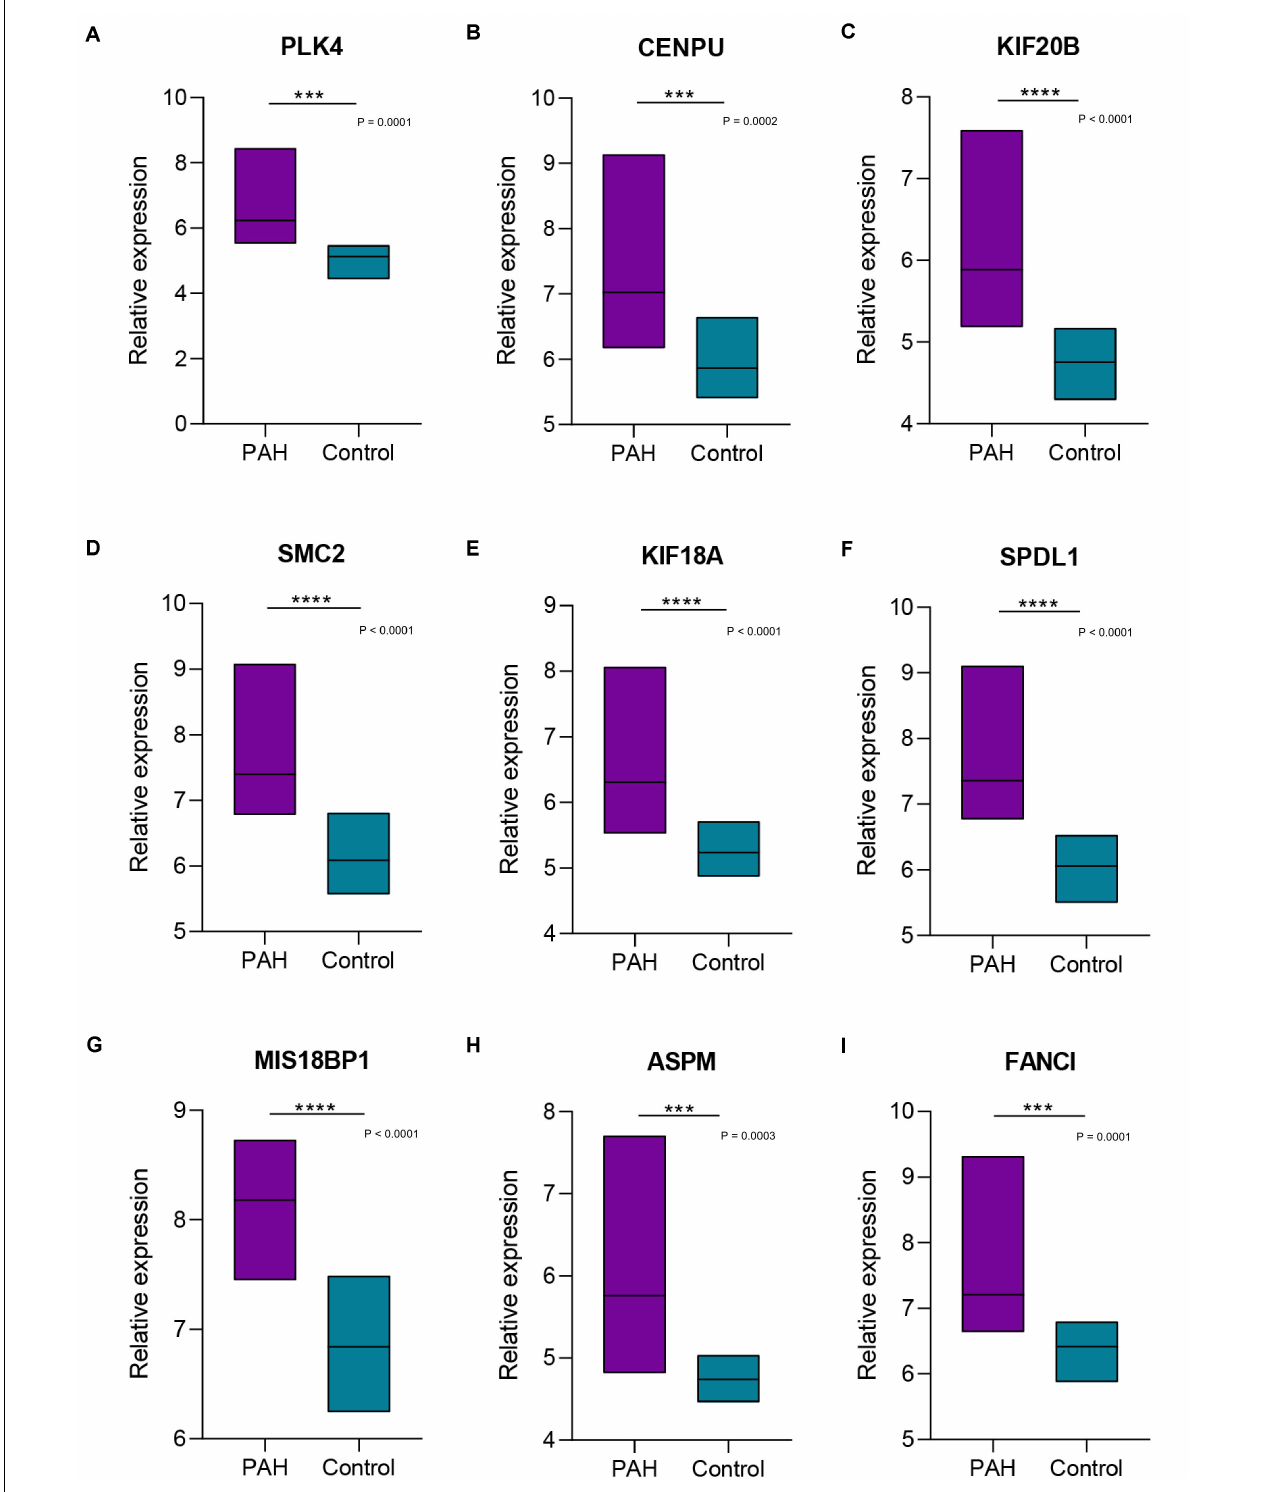
FIGURE 8 | Boxplots of the expression levels of nine hub genes in GSE117261. The expression of the nine key genes [PLK4 (A) , CENPU (B) , KIF20B (C) , SMC2 (D) , KIF18A (E) , SPDL1 (F) , MIS18BP1 (G) , ASPM (H) , FANCI (I) ] was statistically significantly elevated in pulmonary arterial hypertension tissues compared with their expression in healthy lung tissues. ***, **** Indicate significant correlations at P < 0.001, P < 0.0001, respectively.